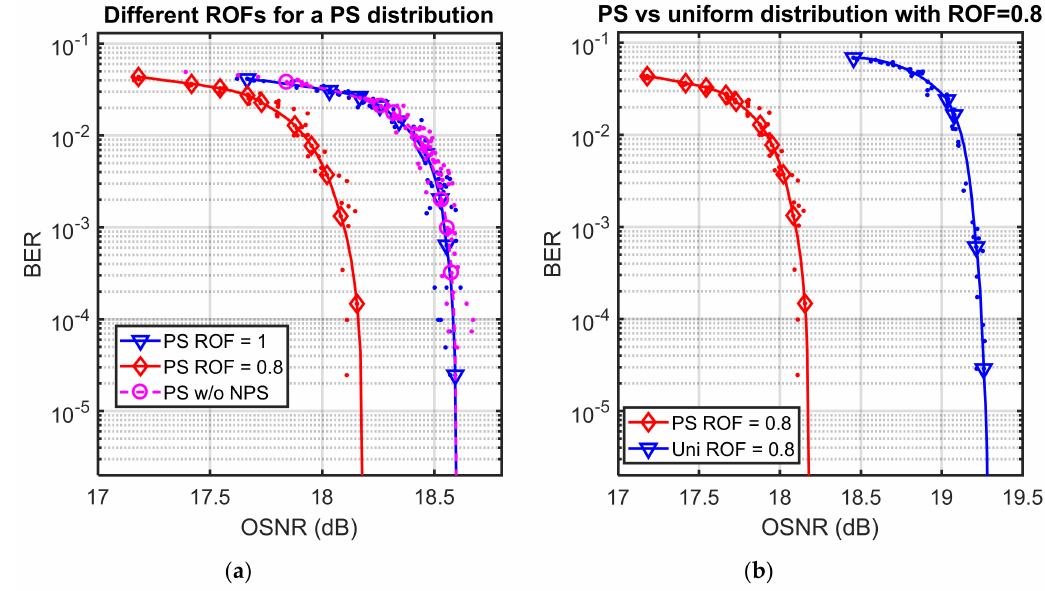
Figure 7. BER performance for: ( a ) a PS distribution with di ff erent ROFs and without NPS, and ( b ) a PS and uniform distribution comparison with the same ROF. OSNR: optical signal-to-noise